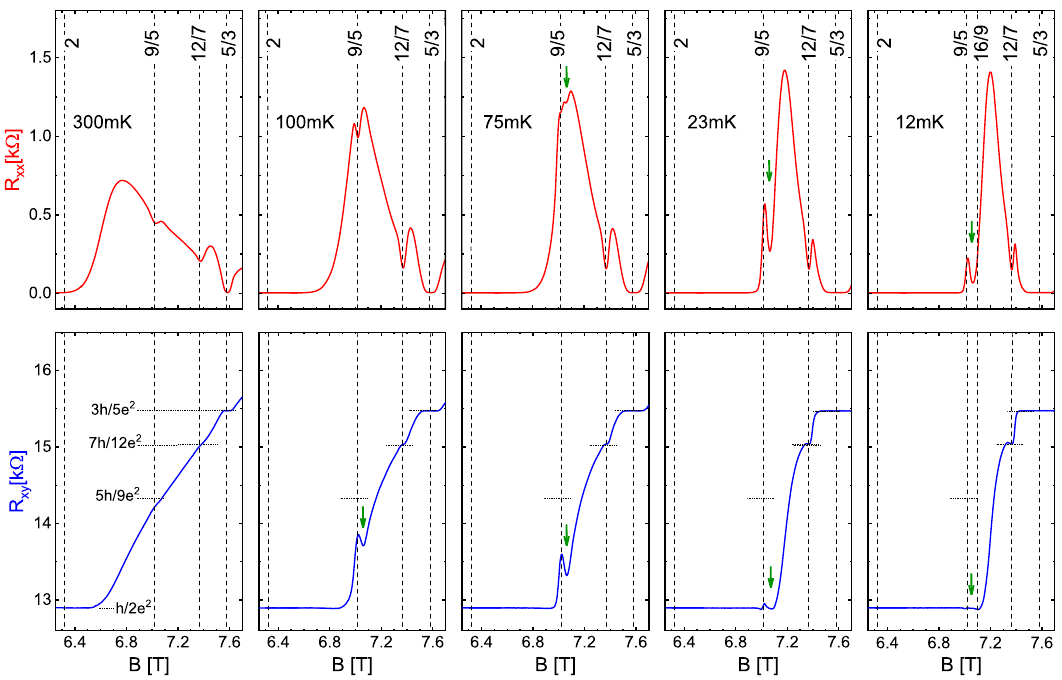
Fig. 2 The dependence on temperature T of the magnetoresistance R xx and Hall resistance R xy of Sample 1 in the range of fi lling factors 5/3 < ν < 2. Labels on vertical dashed lines are fi lling factors ν of interest. The electron solid we refer to as the reentrant integer quantum Hall Wigner solid (RIQHWS) is located between fi lling factors ν = 9/5 and 16/9 and it is marked by